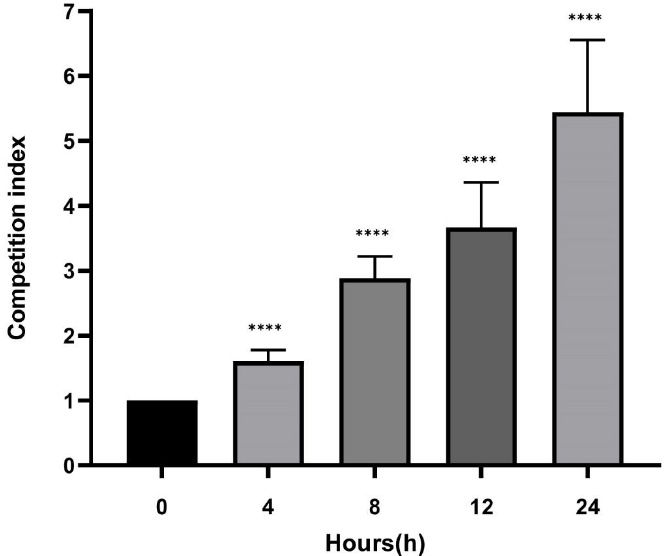
Figure 5. In vitro bacterial competition experiment of three group. N1/K1, N2/K2, N3/K3 mixed inoculum were grown in vitro; the competition index is shown from 0 to 24 h. **** p < 0.001 between 0 and time of inoculation. Error bars represent standard deviation.